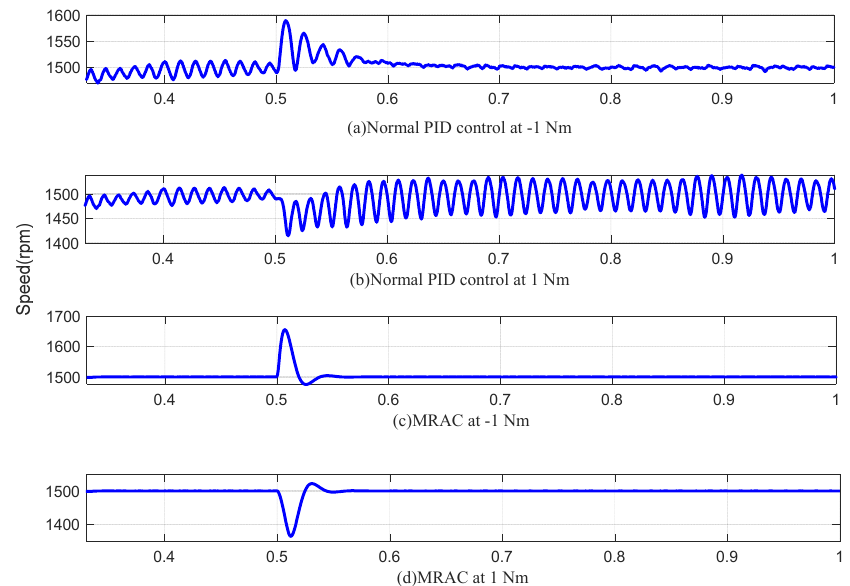
Figure 7. ( a ) Normal PID control at − 1 N · m; ( b ) normal PID control at 1 N · m; ( c ) FOMRAC at − 1 N · m; ( d ) FOMRAC at 1 N · m.